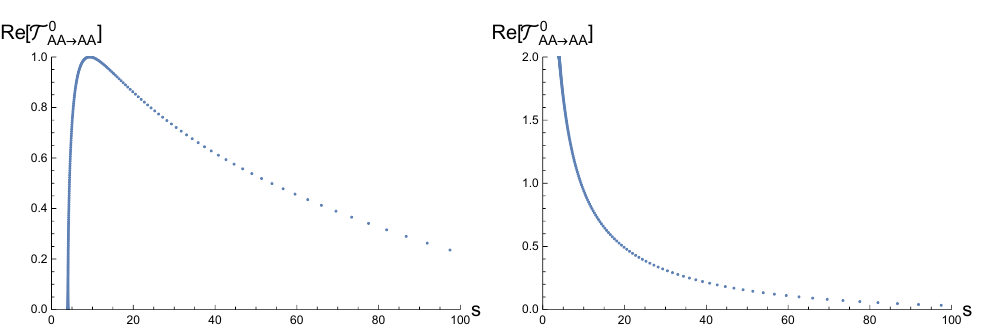
Figure 13 . Real and imaginary parts of the spin 0 interacting part of the AA → AA partial amplitude for λ 0 = 2 . 66 which leads to a/a free = 1 . 2002 . It is constructed for N max = 20 and L max = 30 .